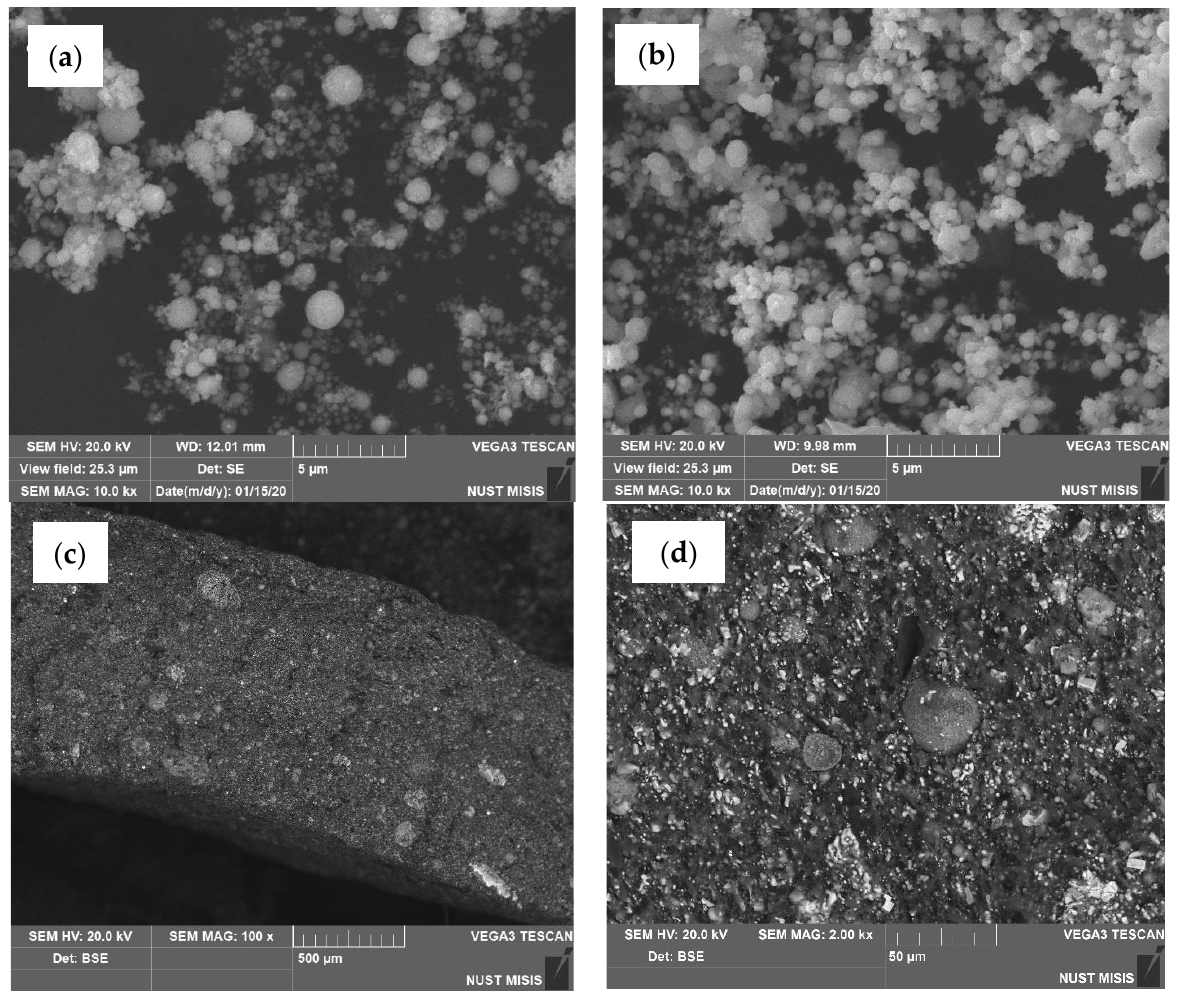
Figure 2. SEM micrographs of ( a ) the native and ( b ) reduced dust powder and ( c) , ( d ) composite based on the dust (75 wt.% with MWCNT). The method of X-ray fluorescence spectroscopy combined with X-ray diffraction was used to quantify the phase composition (Figure 3).